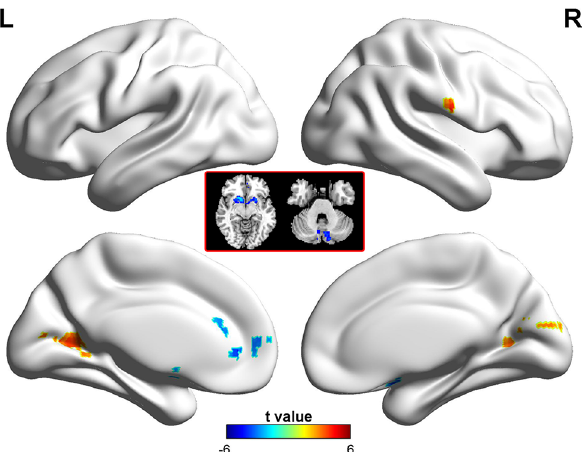
Fig 1. Brain regions showing abnormal ALFF in patients with BECTS. The warm (red) and cold (blue) colors represent higher and lower ALFF, respectively, in patients compared with controls (P < 0.05, corrected). Color bar represents t values.